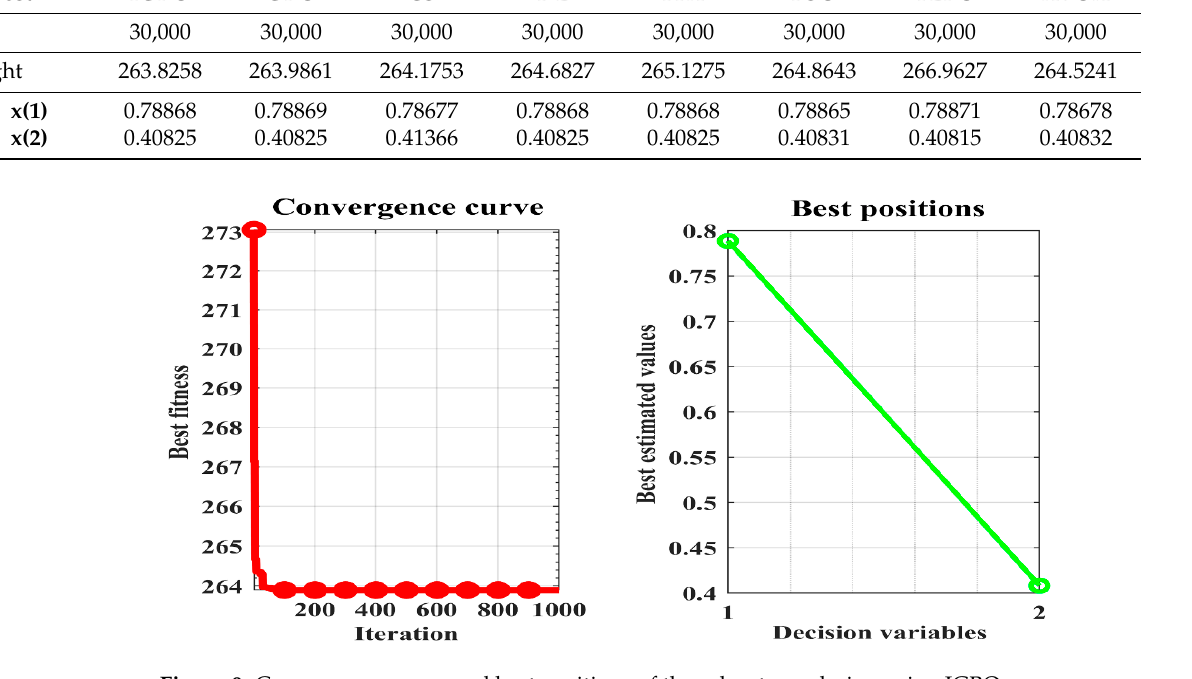
Figure 9. Convergence curve and best positions of three-bar truss design using IGBO.